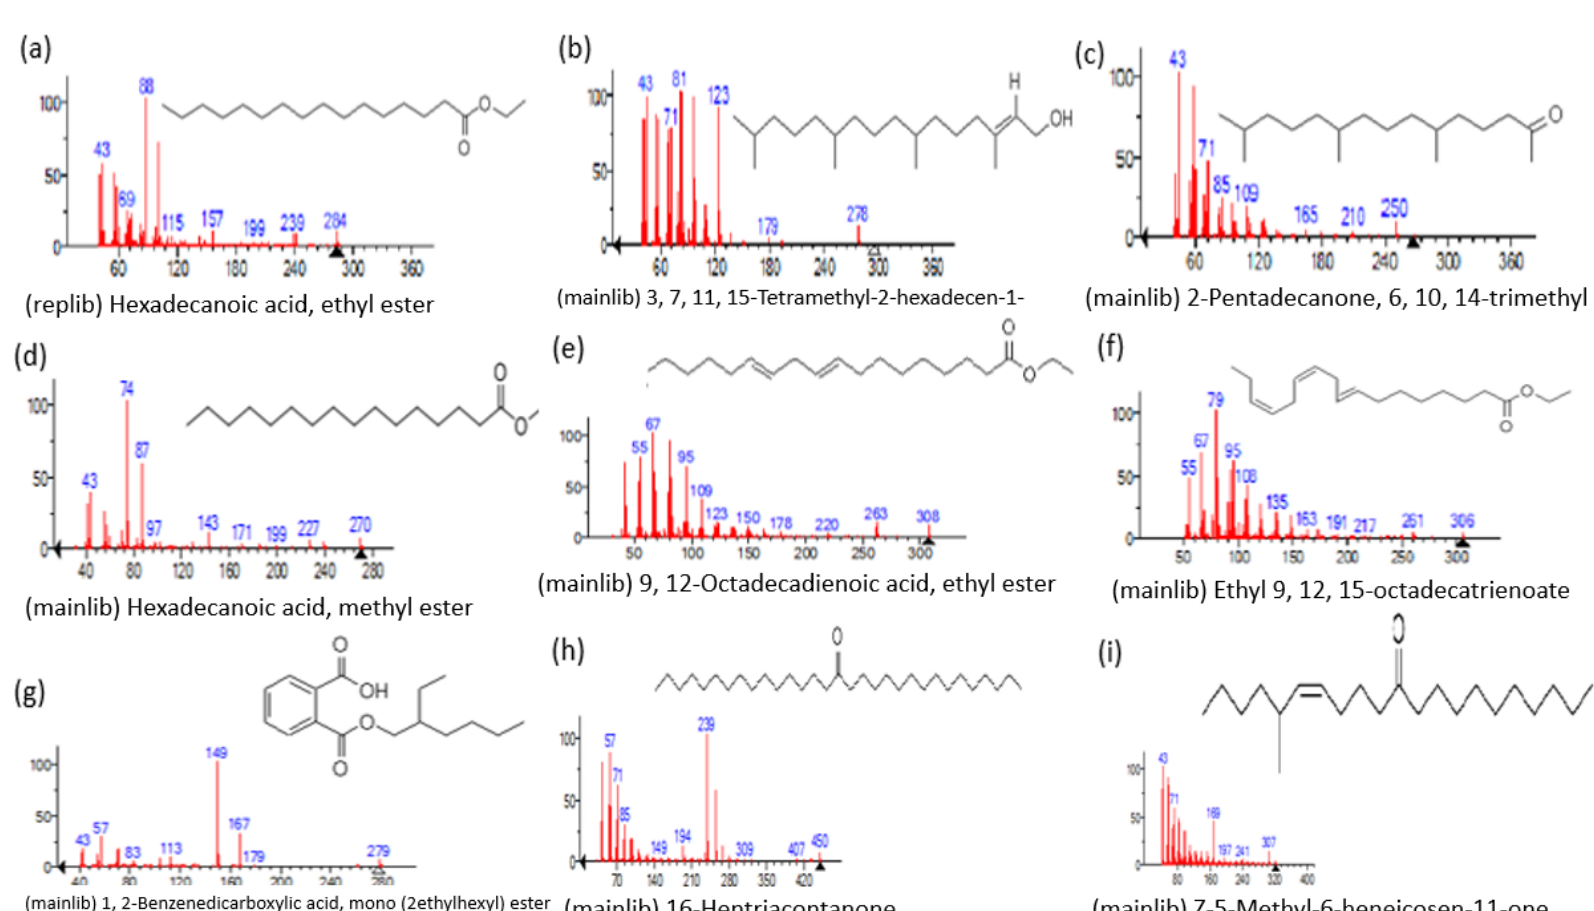
Figure 4. Representing the mass spectrum of Hexadecanoic acid, ethyl ester with RT = 41.613 ( a ), 3, 7, 11, 15 -Tetramethyl-2-hexadecen-1-ol with RT = 41.140 ( b ), 2-Pentadecanone, 6, 10, 14-trimethyl- with RT = 41.303 ( c ), Hexadecanoic acid, methyl ester with RT = 43.470 ( d ), 9,12-Octa decadienoic acid, ethyl ester with RT = 54.297 ( e ), Ethyl 9,12,15-octadecatrienoate with RT = 54.767 ( f ), 1,2-Benzenedicarboxylic acid, mono(2-ethylhexyl) ester with RT = 80.831 ( g ), 16-Hentriacontanone with RT = 91.164 ( h ), and Z-5-Methyl-6-heneicosen-11-one with RT = 92.799 ( i